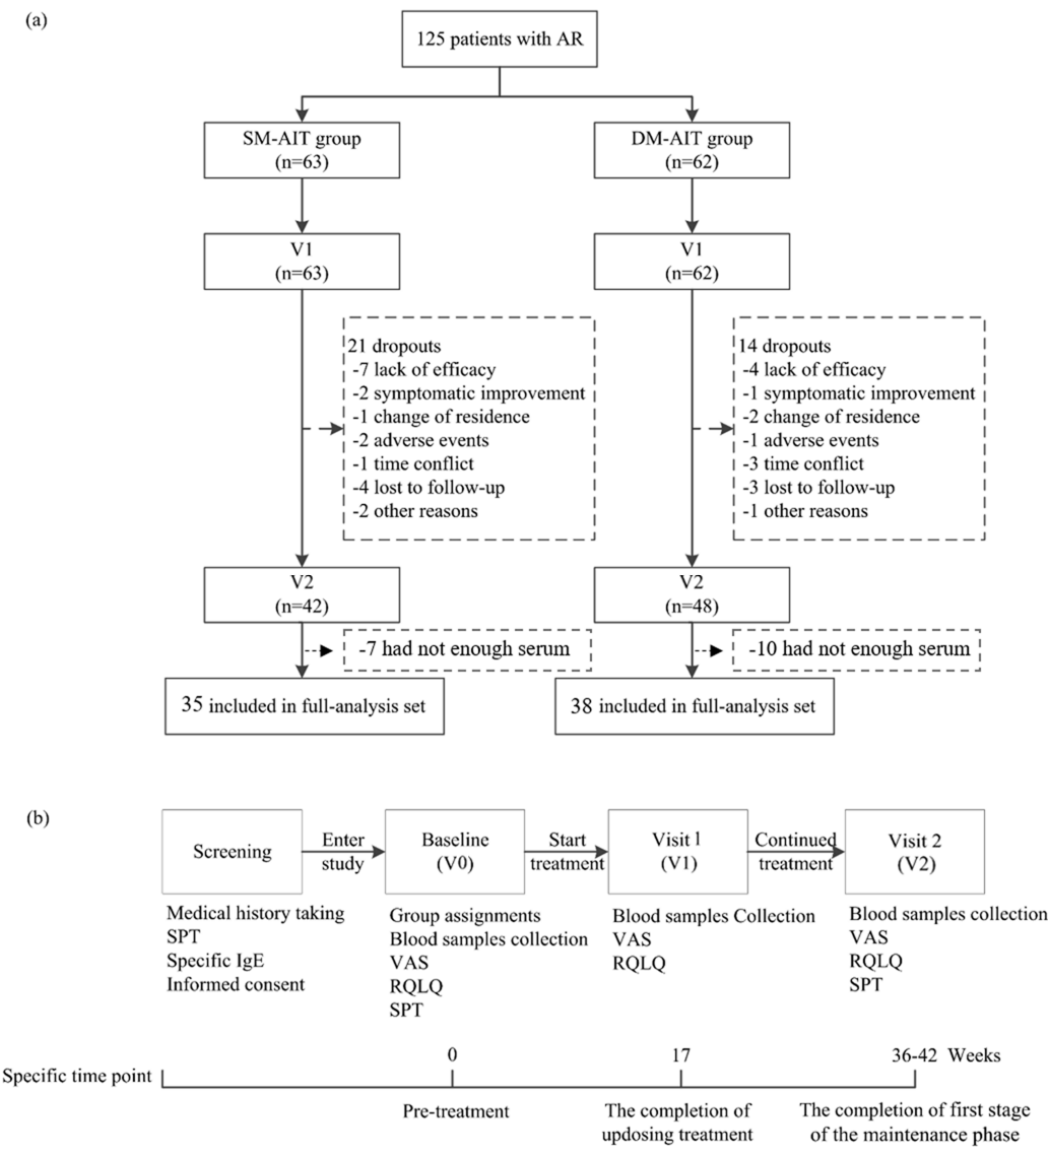
Figure 1. Trail profile ( a ) and flow chart ( b ). Table 1. Baseline characteristics and demographics.